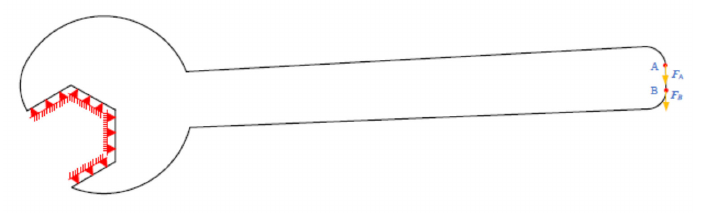
Figure 11. The problem description.